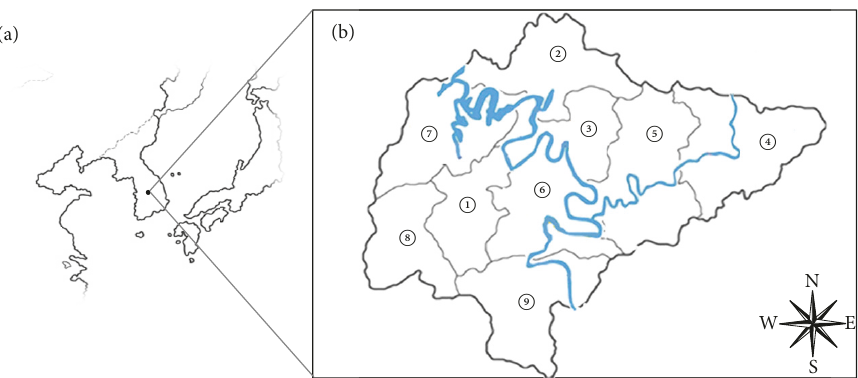
Figure 1: Geographic locations of the surveyed areas. Map shows (a) the Korean Peninsula and (b) the Okcheon-gun County of the Chungcheongbuk-do Province of Korea. The Geum River is shown in blue. Individual villages are shown on the map as follows: A Okcheon- eup, B Annae-myeon, C Annam-myeon, D Cheongsan-myeon, E Cheongseong-myeon, F Dongi-myeon, G Gunbuk-myeon, H Gunseo- myeon, and 0